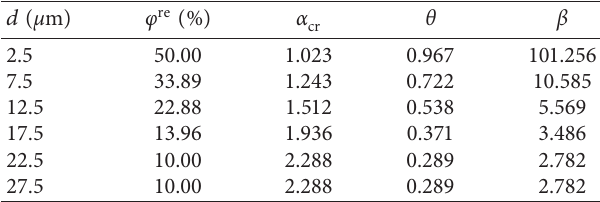
Table 12: Parameter values for P distribution.